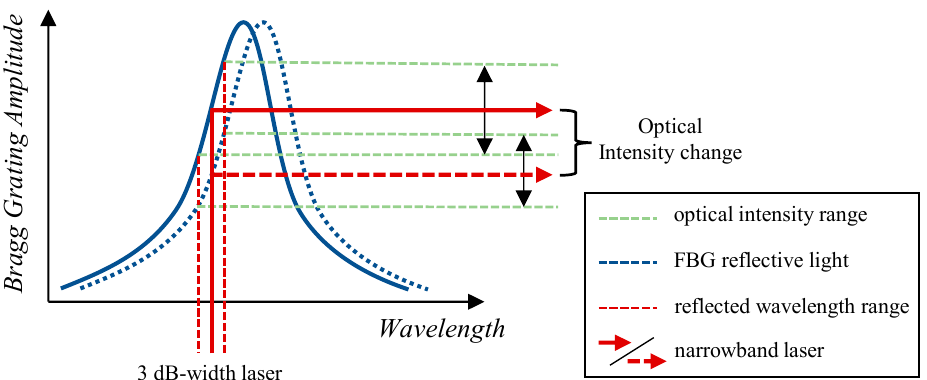
Figure 2. Schematic of ultrasound high-speed FBG demodulation.